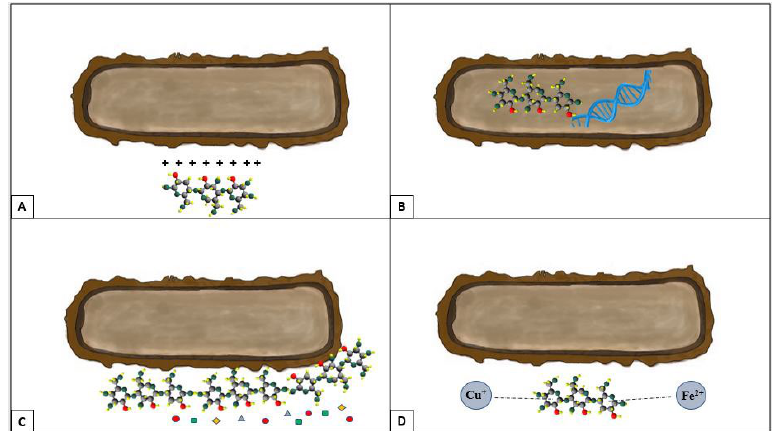
Figure 2. Chitosan antimicrobial mechanisms of action. ( A ) = Electrostatic interactions with the cell wall of Gram-positive bacteria [93–96]; ( B ) = Interaction with bacterial DNA [98]; ( C ) = Formation of chitosan layer on the yeast cell surface [99]; ( D ) = Chelation of micronutrients and metal ions with impact on the Gram-negative bacteria cell wall [100–102].